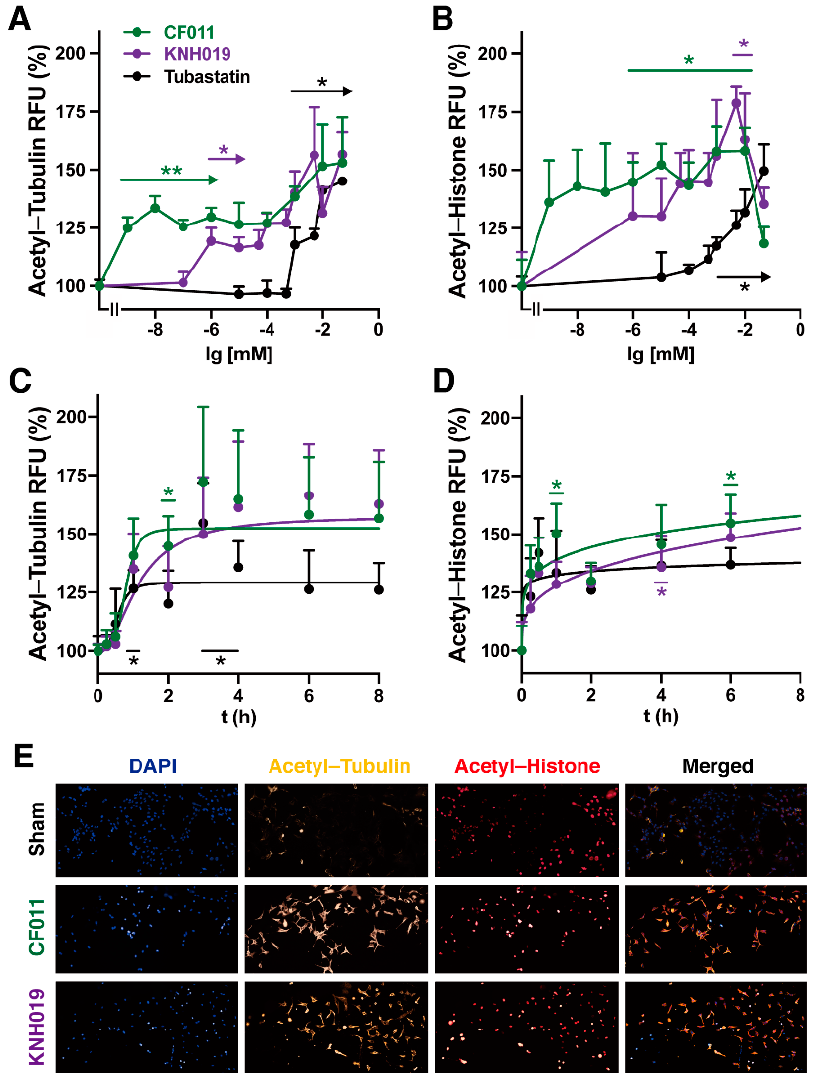
Figure 5. Cell-based assessment of HDAC activity and selectivity. Dose and time-dependency of tubulin and histone acetylation by test compounds. A549 cells were treated with ( A , B ) different concentrations (0–50 µM) of CF011 , KNH019 and tubastatin for 24 h or with ( C , D ) 1 µM over different time intervals before ( A , C ) tubulin acetylation or ( B , D ) histone acetylation were automatically quantified using high content imaging. Data represent the average of four independent experiments with four replicate wells/experiments. The statistical significances of effects compared to the untreated control were analysed using Brown–Forsythe and Welch one-way ANOVA analyses using Graph Pad Prism. The significance was set as * 0.05 > p ≥ 0.01, ** 0.01 > p ≥ 0.002. Error bars represent the Standard Error of Mean (SEM). ( E ) Representative fluorescence images show tubulin acetylation (yellow), histone acetylation (red) and nuclear counterstain (DAPI, blue) after 24 h of exposure to test compounds. Secondary antibodies were detected using excitation/emission filters for CY3 (excitation: 542/27 nm, emission: 597/45 nm), CY5 (excitation: 632/22 nm, emission: 684/25 nm) and DAPI (excitation: 390/18 nm, emission: 435/48 nm), respectively.